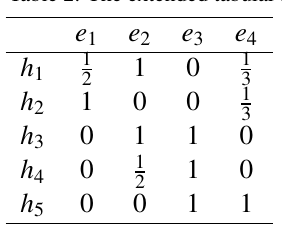
Table 2. The extended tabular representation of ( F , A